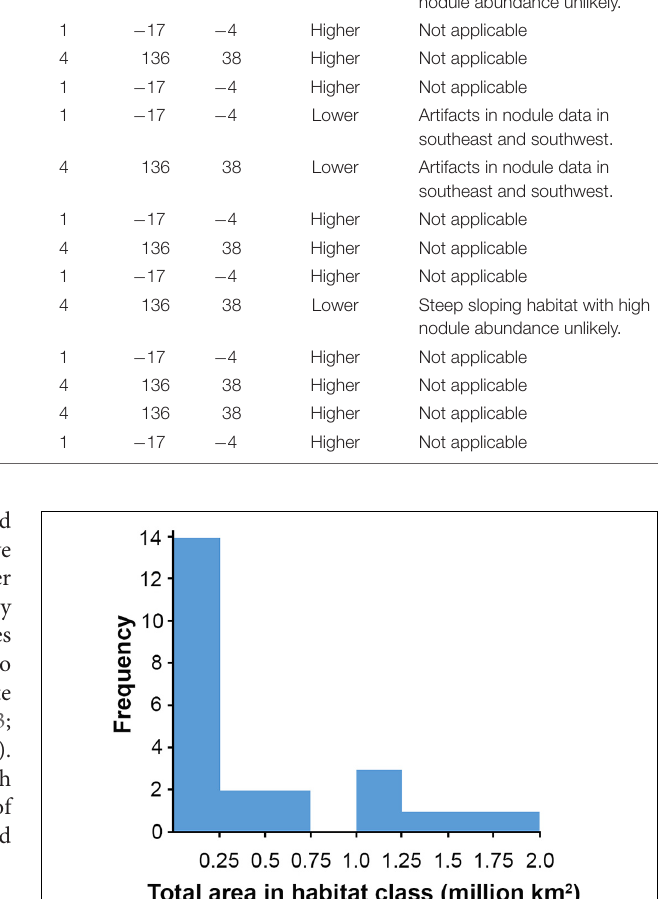
In the current APEI network, 14 habitat classes (nearly 60% of the total number of habitat classes in the area) have less than 10% of their area represented within APEIs, and 10 of these are represented by less than 5% ( Figure 8 ). These 14 habitat classes have a range of environmental conditions including